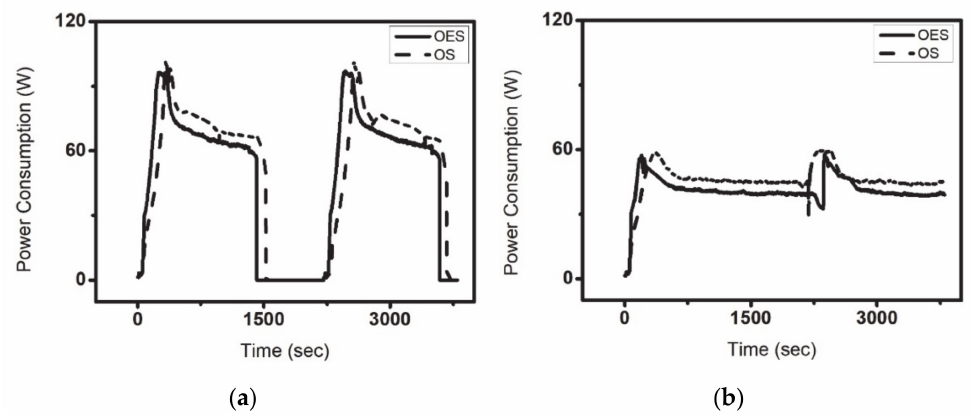
Figure 5. Power consumption trend with ( a ) OTR = 0.7; ( b ) OTR = 1.